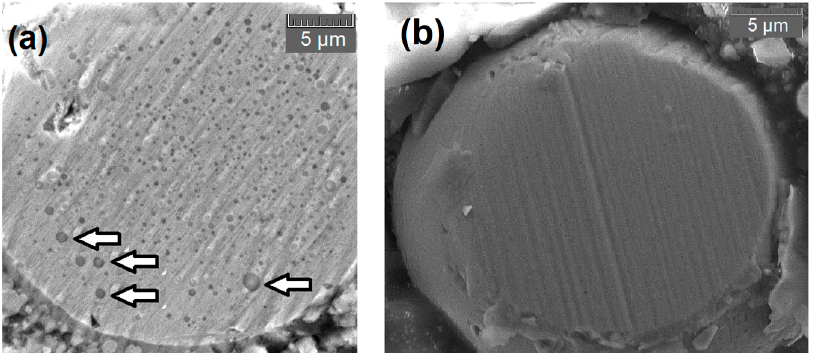
Figure 8. ( a ) imprisoned oxides in transversal section droplet of 309L. The arrows indicate few of many circular oxides. ( b ) Cross section of 70S-6 droplet do not have internal oxides.